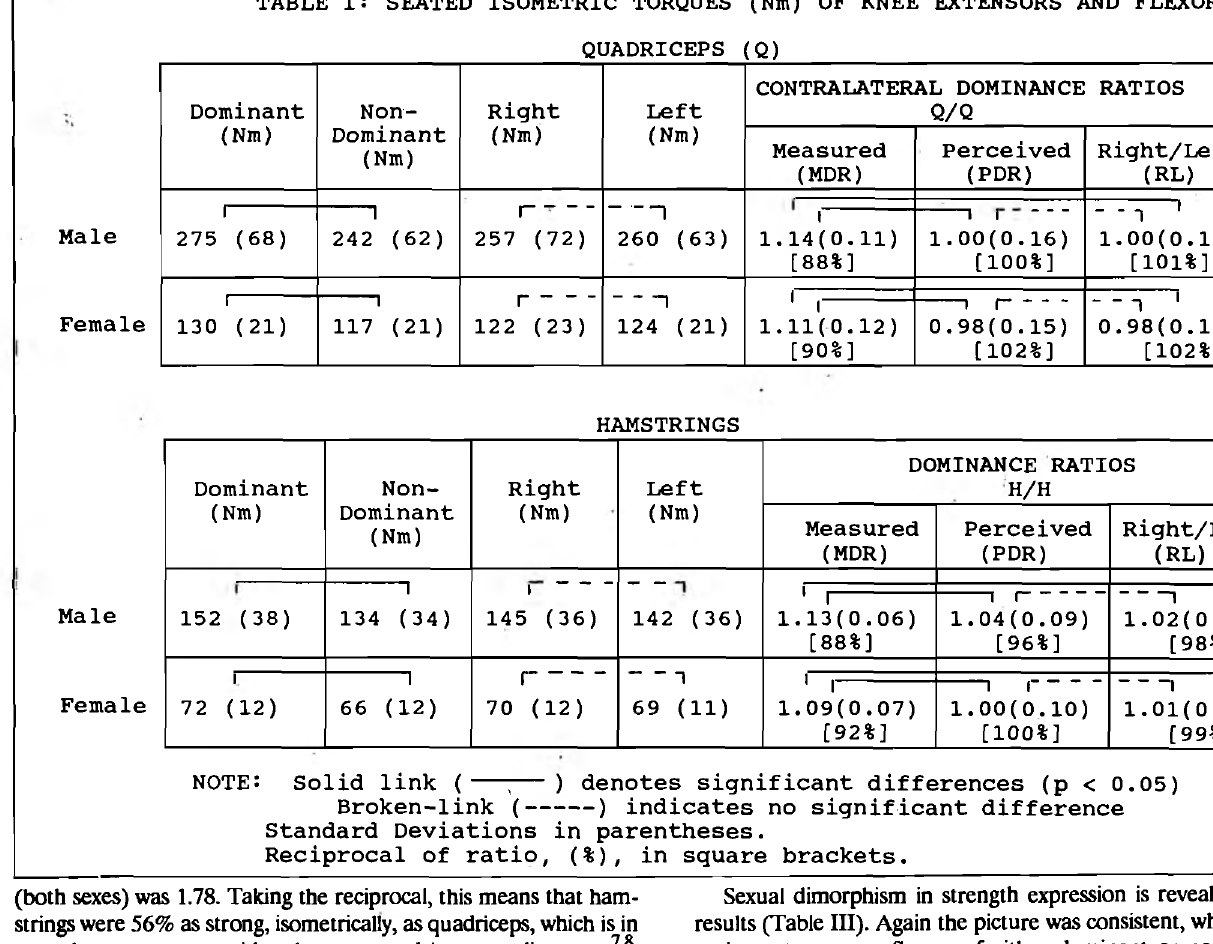
TABLE i: SEATED ISOMETRIC TORQUES (Nm) OF KNEE EXTENSORS AND FLEXORS QUADRICEPS (Q)